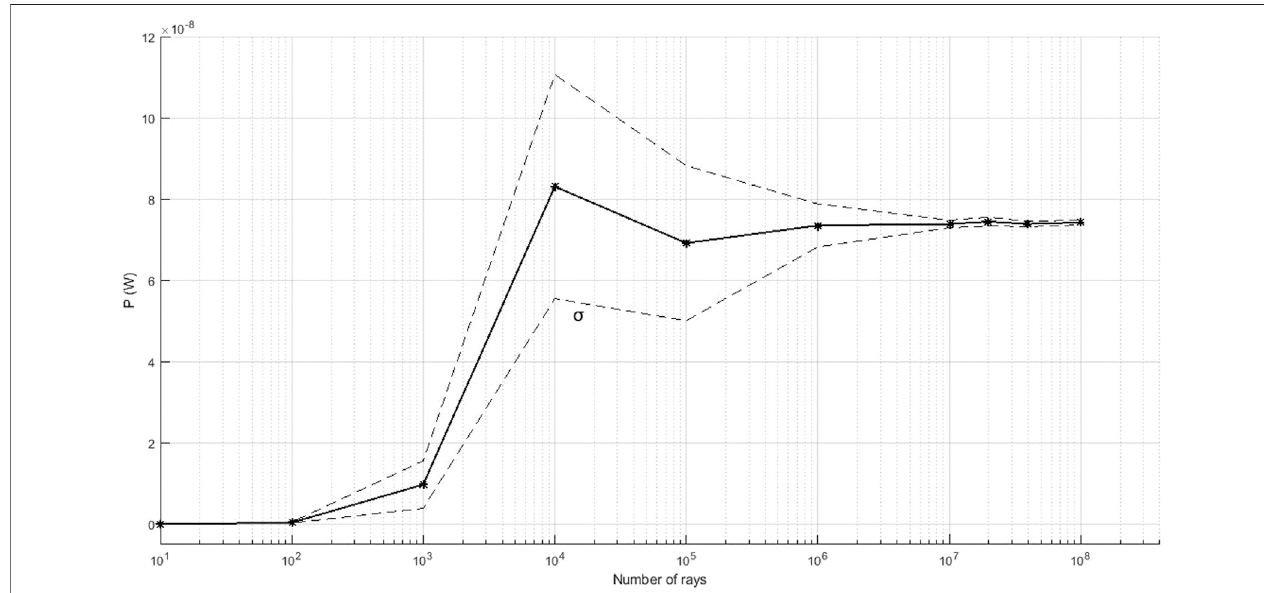
FIGURE 3 | Relationship between the number of rays and the total re fl ected power in the detector. The dotted line represents the standard deviation.